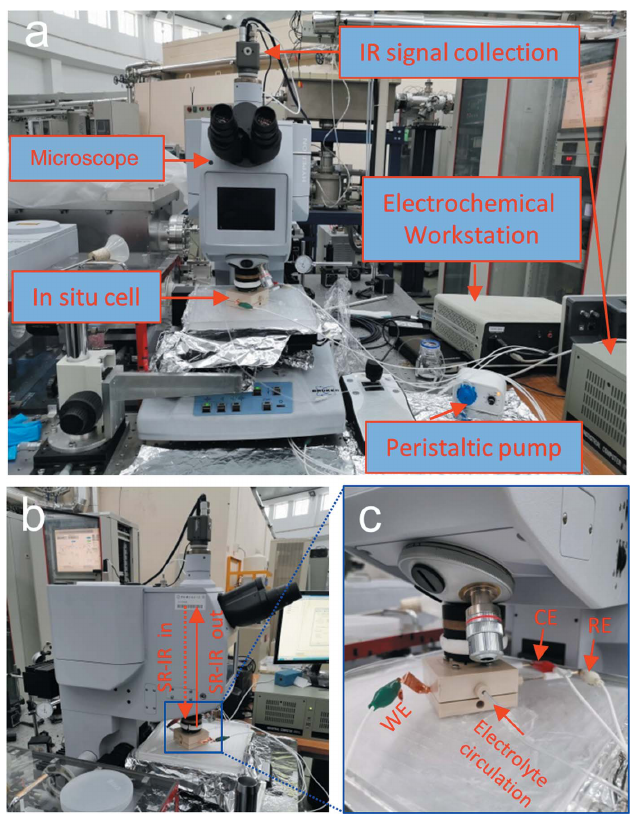
Figure 2 ( a ) Photograph of the equipment used for the in situ SR-FTIR measurements. ( b ) Enlarged photograph of the testing microscope instrumentation. ( c ) Enlarged photograph of the in situ cell, where WE, CE and RE are the working, counter and reference electrodes,